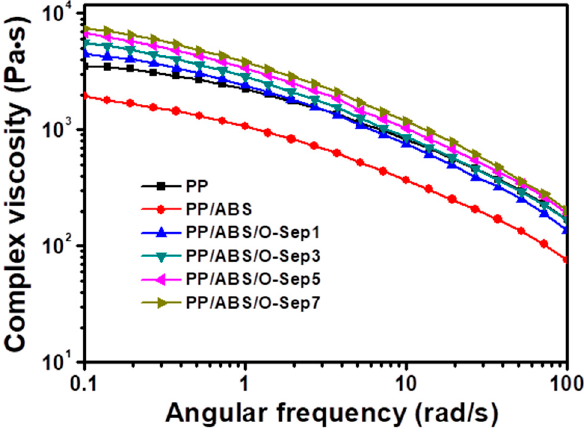
Figure 7. Plots of complex viscosity versus angular frequency of PP and PP / ABS / O-Sep nanocomposites at 210 °C.